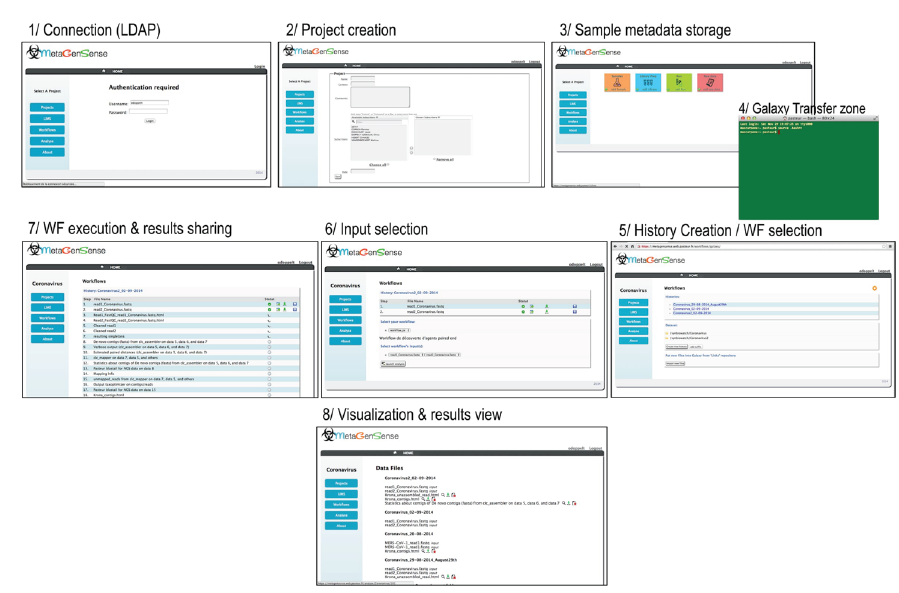
Figure 2. MetaGenSense functioning starting with user